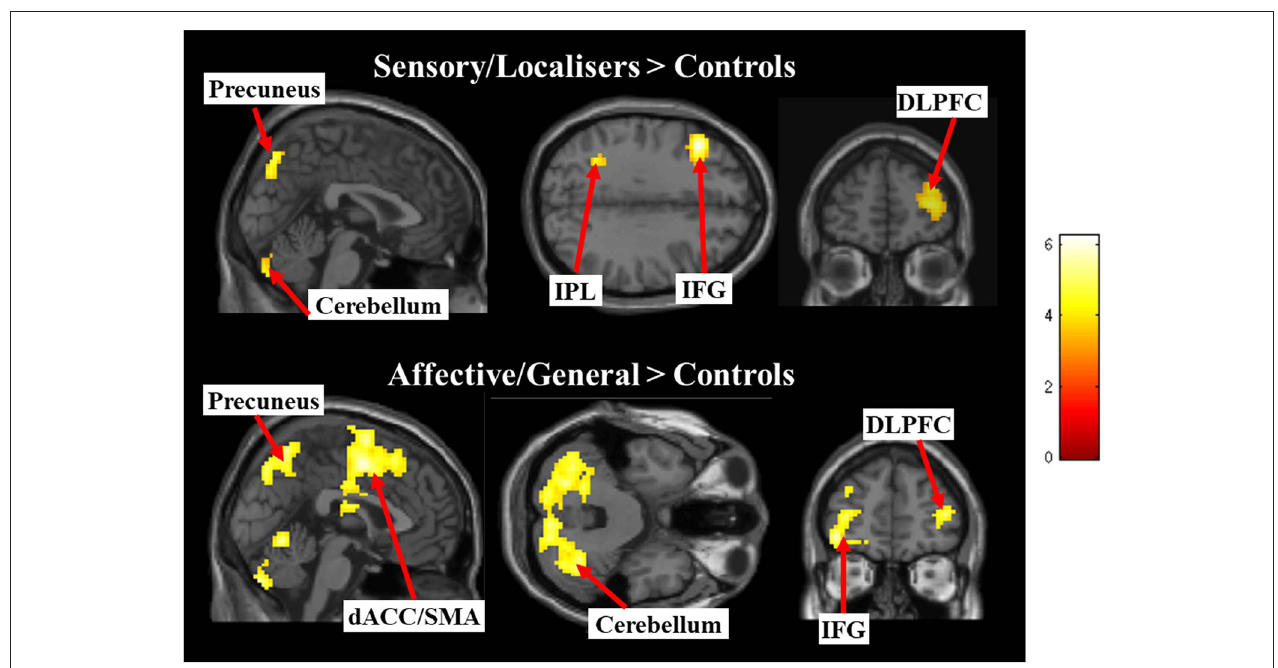
FIGURE 4 | Images display between group effects for Pain > Pain contrasts for each of the responder groups compared with controls. Contrasts use a whole brain p < 0.001 (uncorrected) with a cluster extent threshold of k = 10 (the more liberal statistical threshold has only been used for figure display).